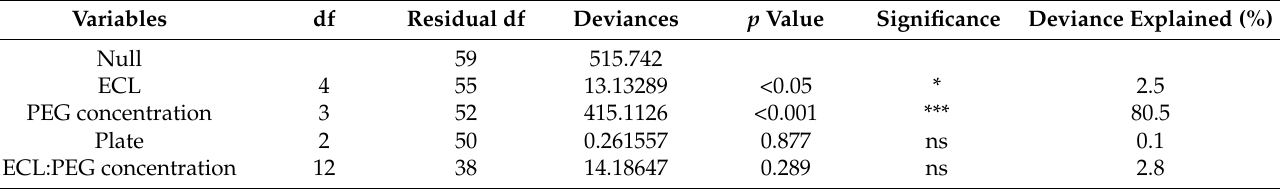
Figure 2. Somatic embryo maturation of sugi S-18 ECL on medium containing different PEG concentrations: ( A ) 10%, ( B ) 15%, ( C ) 17.5%, and ( D ) 20%. Bars: 5 mm. Table 4. Summary of deviances of the generalized linear model (GLM) of data from Table 3 (Effect of polyethylene glycol (PEG) concentration on somatic embryo maturation efficiency of sugi embryogenic cell lines (ECLs)). Deviance of the variable “null” indicates the null deviance (deviance of the null model), and other deviances indicate the residual deviance (deviance of the variable).